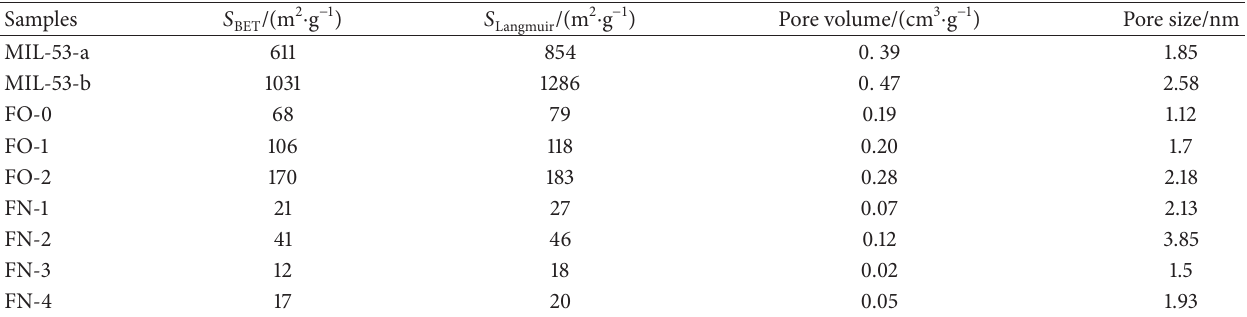
Table 1: Textural properties of